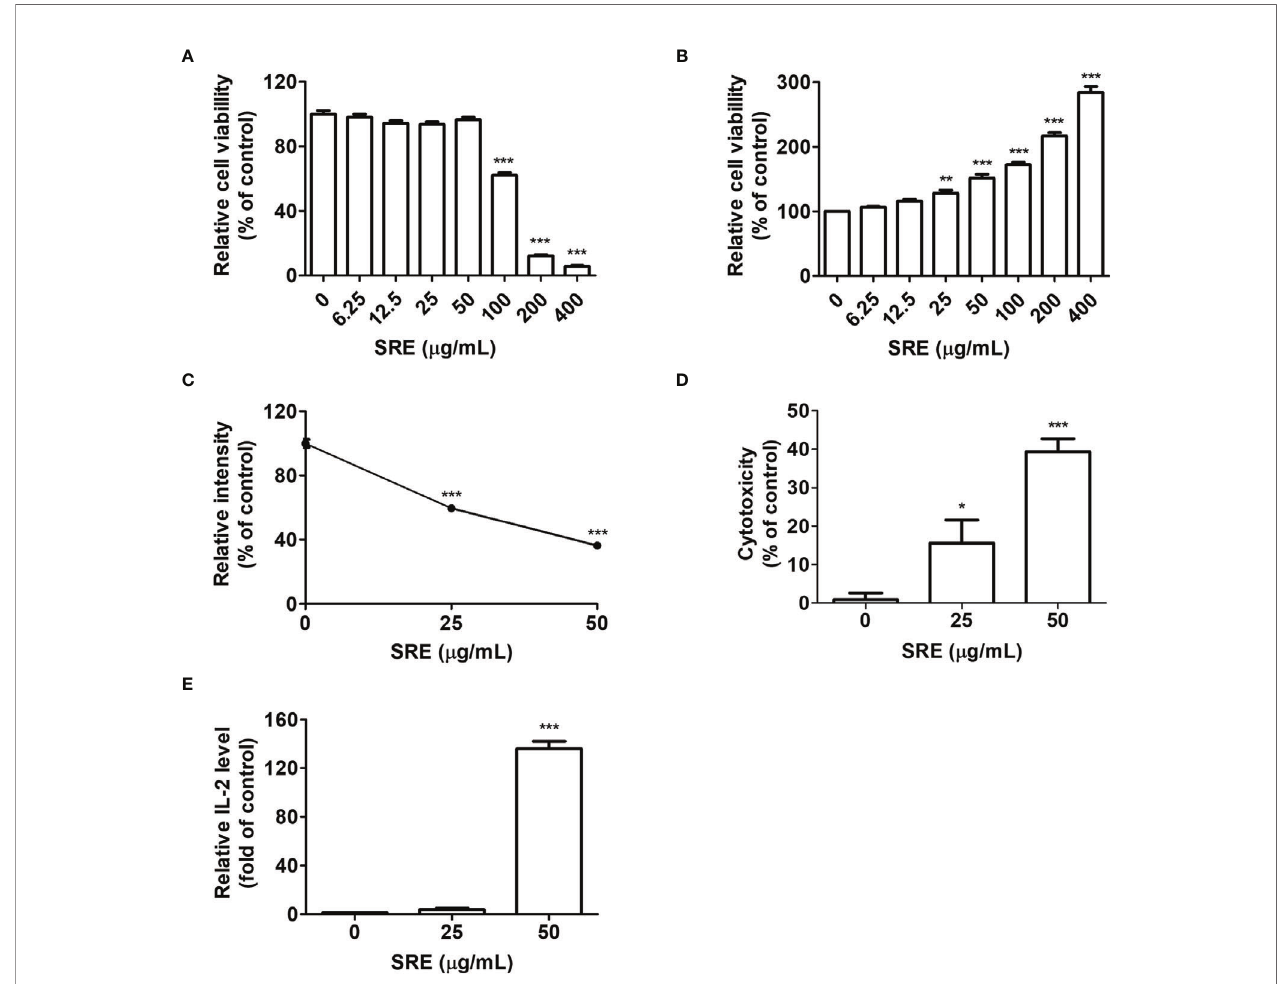
FIGURE 3 | SRE-induced activation of T cells and cytotoxic effect of T cell-mediated cancer cells. (A, B) The cell viability was performed using the CCK-8 assay. Splenocytes were isolated from hPD-L1 MC38 cell-bearing hPD-1 knockin mice. Murine CRC hPD-L1 MC38 cells (A) and hPD-1 mice splenocytes (B) were treated with SRE for 72 hours. (C) Cocultured hPD-L1 MC38 cell viability tested by crystal violet staining; (D) Lactate dehydrogenase (LDH) released by damaged cells, detected via LDH cytotoxicity assay; (E) Relative interleukin-2 (IL-2) level, determined using the mouse IL-2 ELISA set. Data are presented as the mean ± SD. * p < 0.05, ** p < 0.01, and *** p < 0.001 compared to the